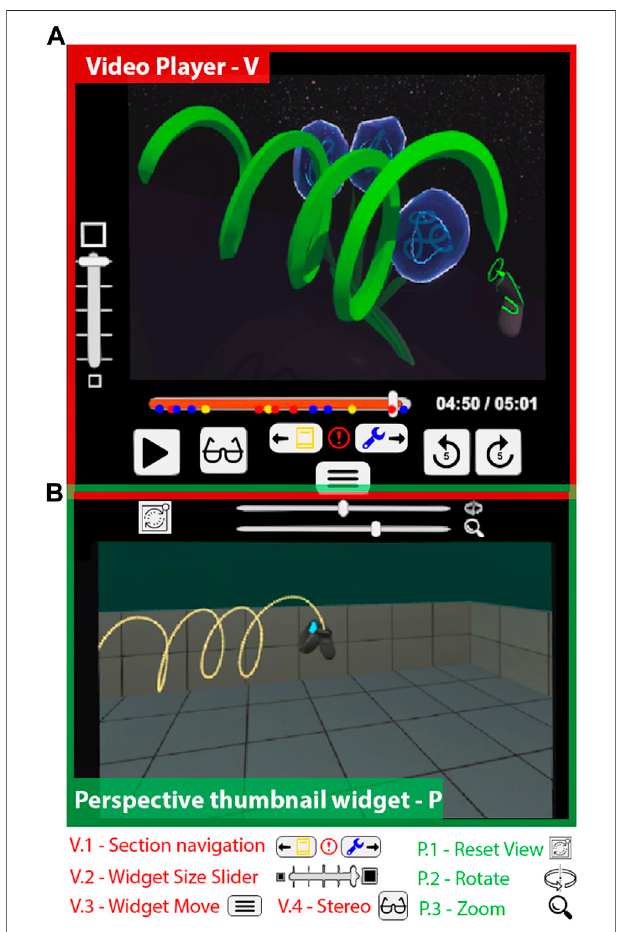
FIGURE11| ThemainpaneloftheTutoriVRsystem.Up(V):Videoplayer interface;Down(P):ThePerspectivethumbnailviewwhichreconstructsin3D, interactions in the corresponding video; V.4 toggles the stereo